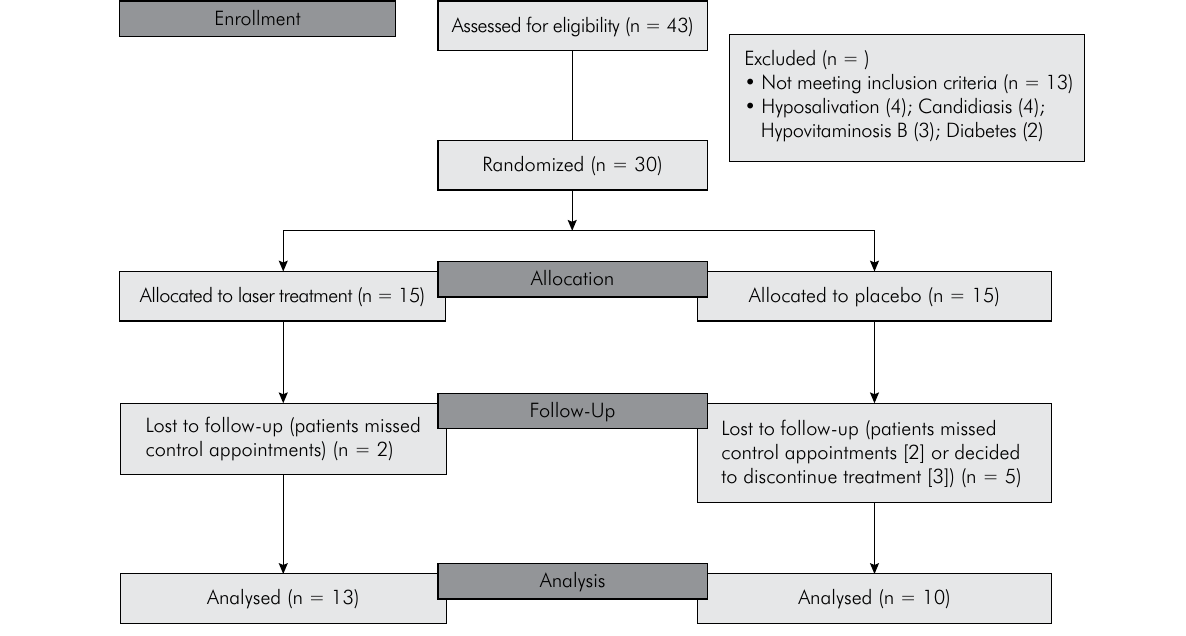
Figure 1. Consort flow diagram